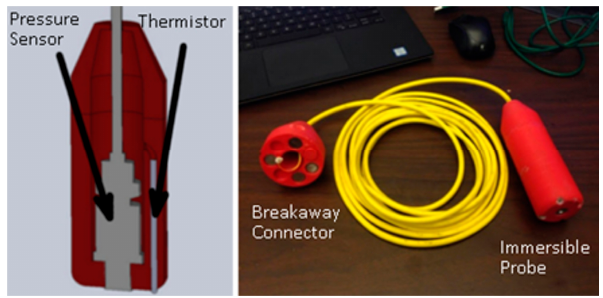
Figure 2. Underwater temperature probe. ( Left ) Probe interior design showing the temperature and pressure (depth) sensors; ( Right ) Umbilical cord with immersible sensor at one end and the breakaway connection at other.